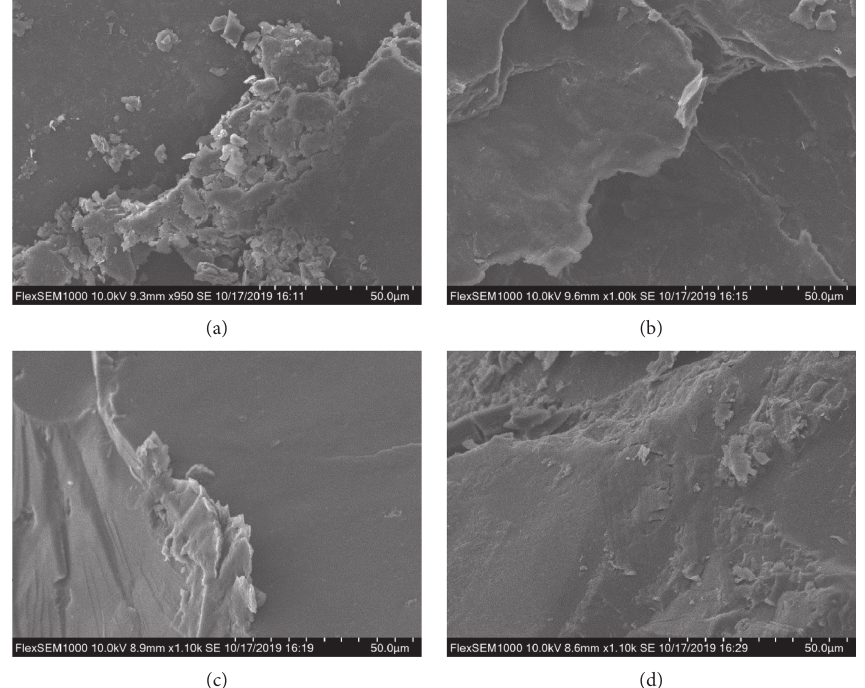
Figure 5: Mesostructures of the soft coal in the different coal seams. (a) No.1 soft coal in the No. 4 coal seam. (b) No. 2 soft coal in the No. 4 coal seam. (c) No. 1 soft coal in the No. 13 coal seam. (d) No. 2 soft coal in the No. 13 coal seam.